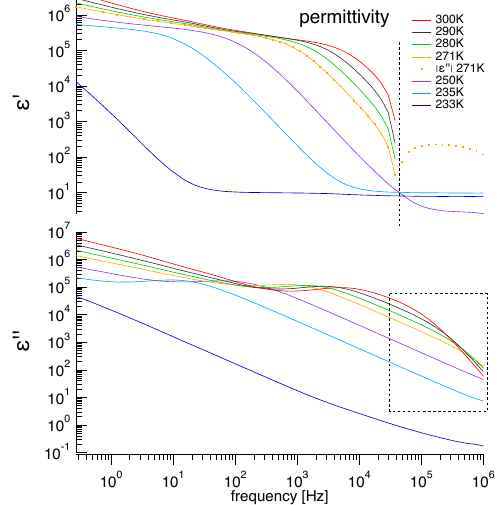
Figure 10. Real and imaginary part of the dielectric permit- tivity of phosphoric acid (PA), measured in cooling with the setup for simultaneous n-DE-spectroscopy and showing anoma- lies for high temperatures at high frequency. For (cid:15) (cid:48)(cid:48) we find at high frequency with increasing temperature an increasingly steeper decay (lower figure; dashed square region). In the same temperature-frequency region the real part of the permittivity (cid:15) (cid:48) turns negative (upper part: r.h.s. of the dashed line). As the data are plotted on a log-log scale, we have highlighted this by adding for 271 K the absolute values of (cid:15) (cid:48) (dots). Note also that crys- tallisation has appeared between T = 235 K and 233 K.